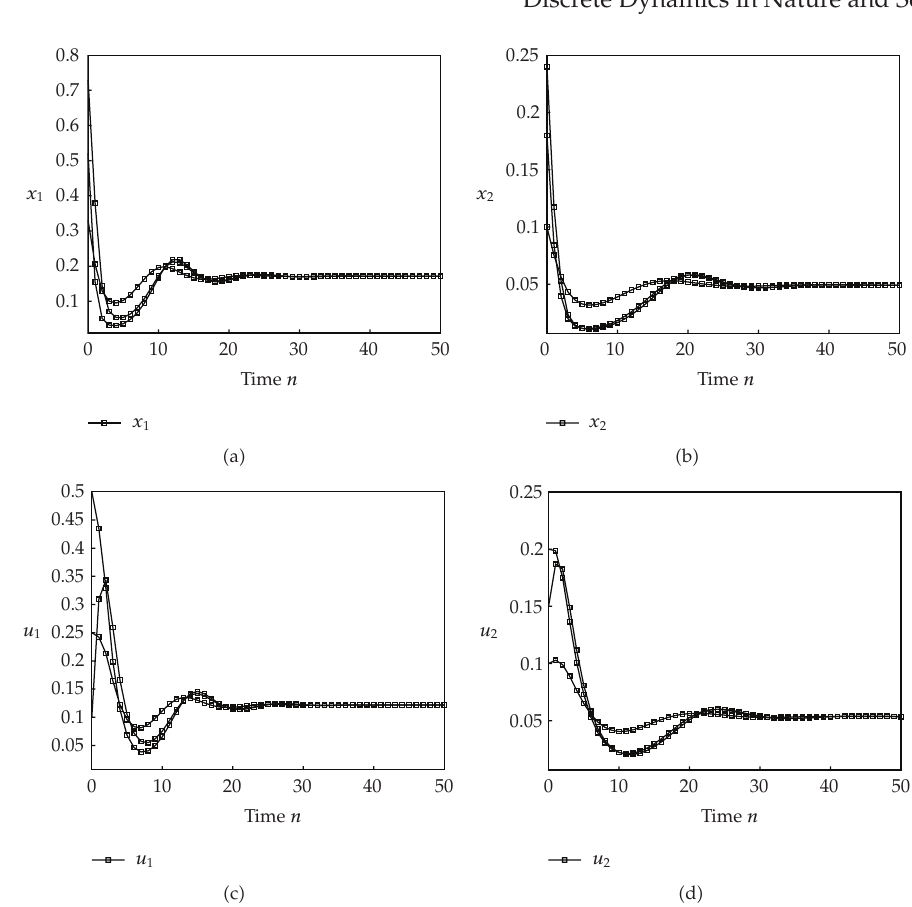
Figure 1: Dynamic behaviors of system (cid:5) 4.1 (cid:6) with initial conditions (cid:5) x 1 (cid:5) s (cid:6) ,x 2 (cid:5) s (cid:6) ,u 1 (cid:5) s (cid:6) ,u 2 (cid:5) s (cid:6)(cid:6) T (cid:7) (cid:5) 0 . 73 , 0 . 1 , 0 . 1 , 0 . 1 (cid:6) T , (cid:5) 0 . 33 , 0 . 24 , 0 . 25 , 0 . 15 (cid:6) T , (cid:5) 0 . 52 , 0 . 18 , 0 . 5 , 0 . 2 (cid:6) T , s (cid:7) − 1 , 0